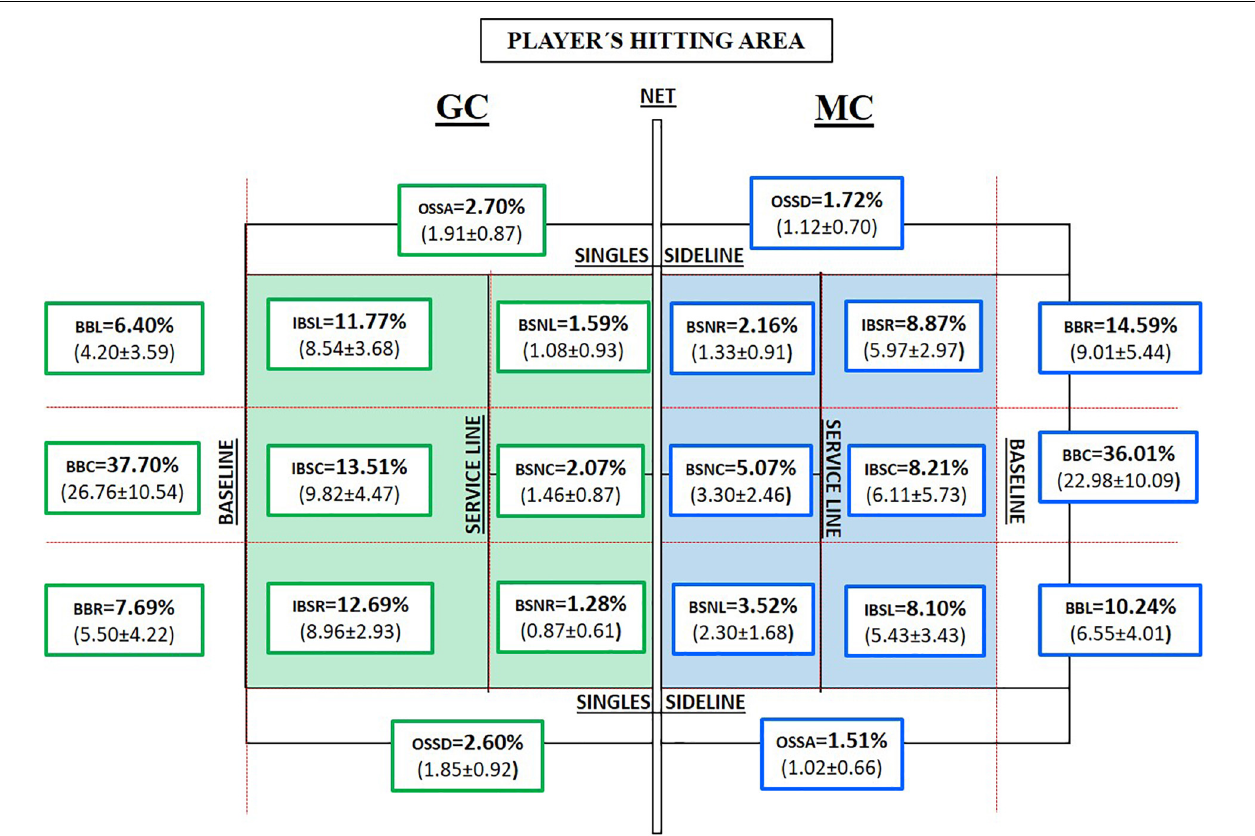
in contrast, GC shows the highest average values of hitting behind the service line inside the court (76% of the sample, d = 0.700, high